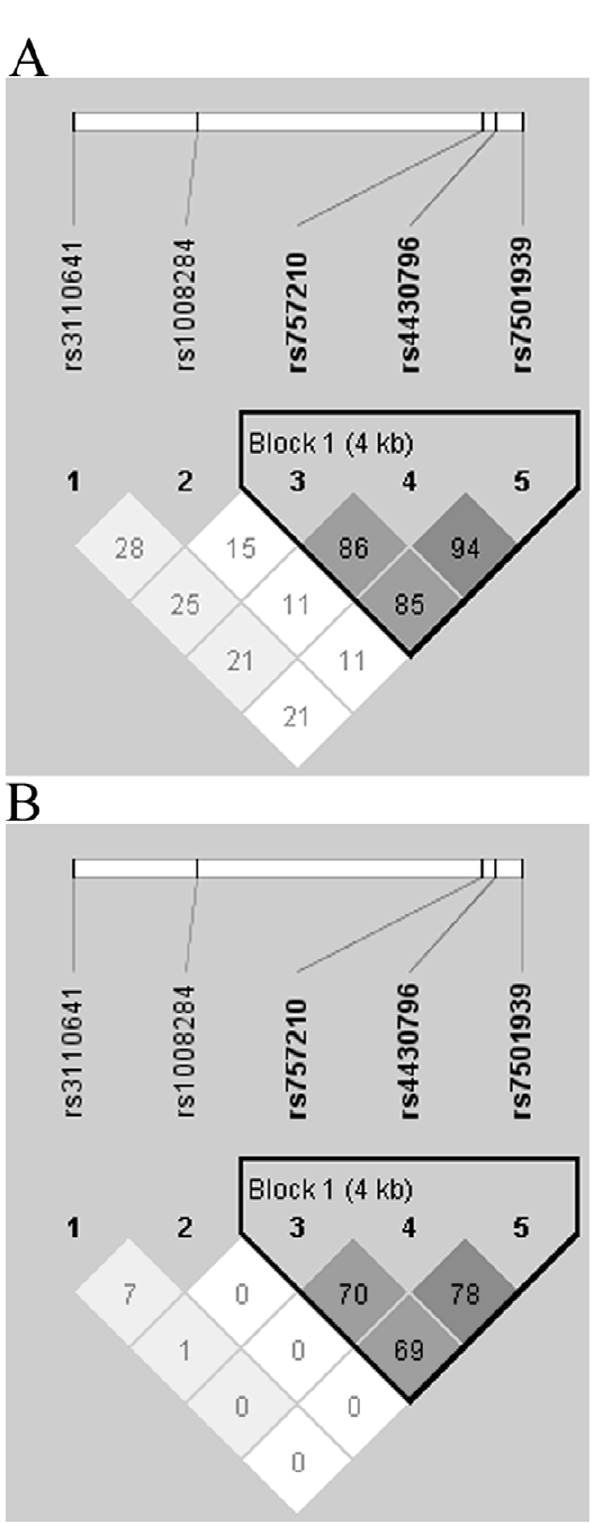
Figure 1. Linkage disequilibrium patterns of five typed SNPs in the Chinese population. This plot was generated using the Haploview program with the confidence intervals setting. One block was determined. The rs number (top: from left to right) corresponds to the SNP name and the number in each square is D 9 values (A) or r 2 values (B) between a pair of SNPs. The measure of LD (D 9 or r 2 ) among all possible pairs of SNPs is shown graphically according to the shade of